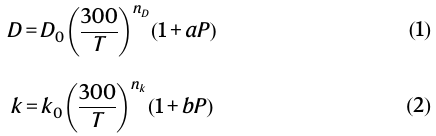
823K. d Pressuredependence of κ at300and 823K. The experimentalerror is